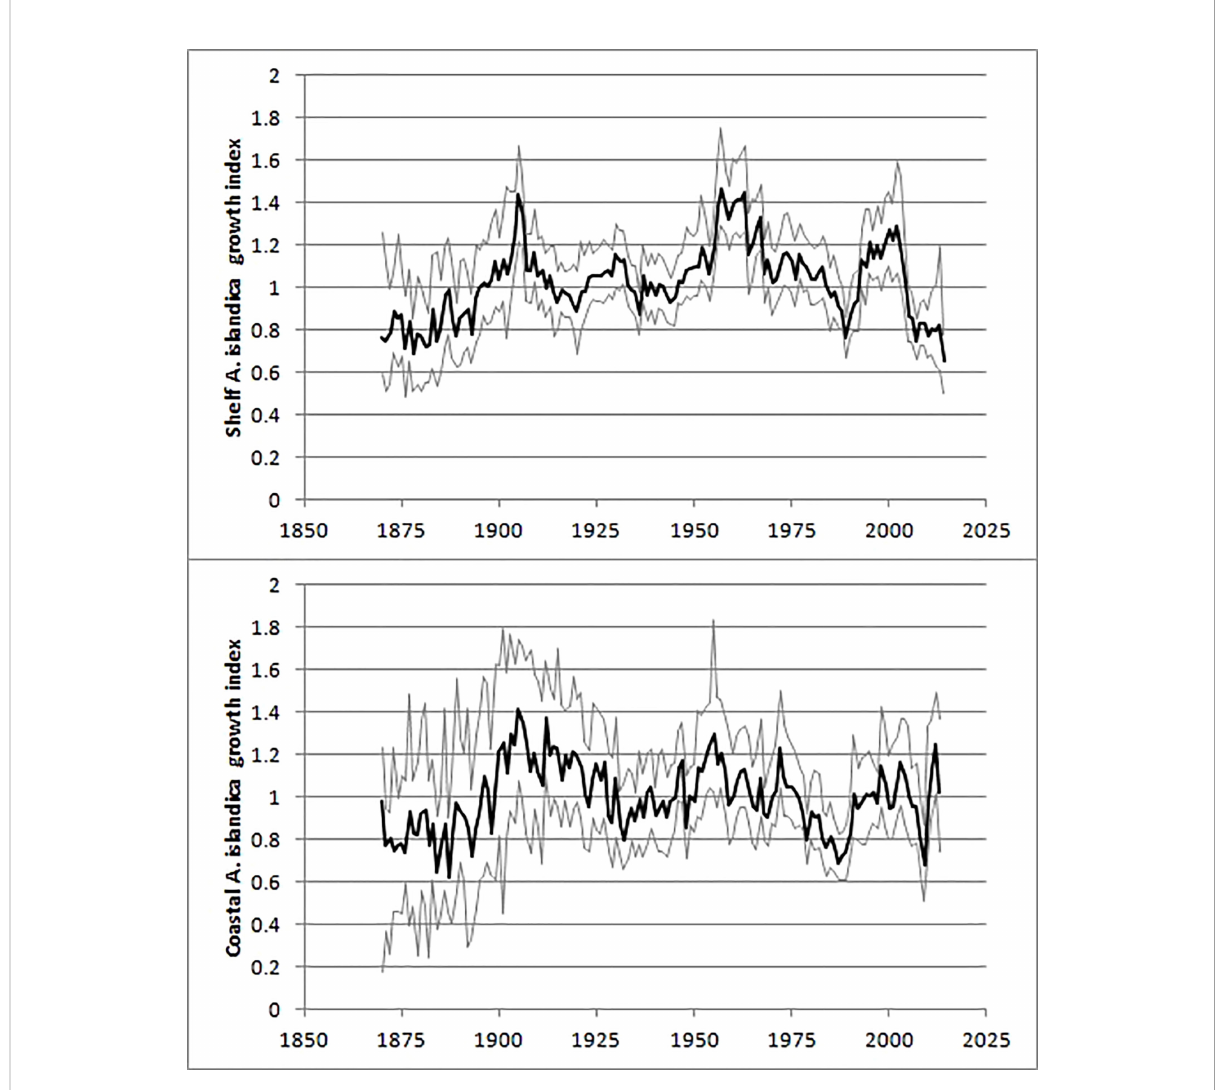
FIGURE 5 The shelf (upper) and coastal (lower) A. islandica growth index. Thin lines indicate the bootstrapped 95% con fi dence